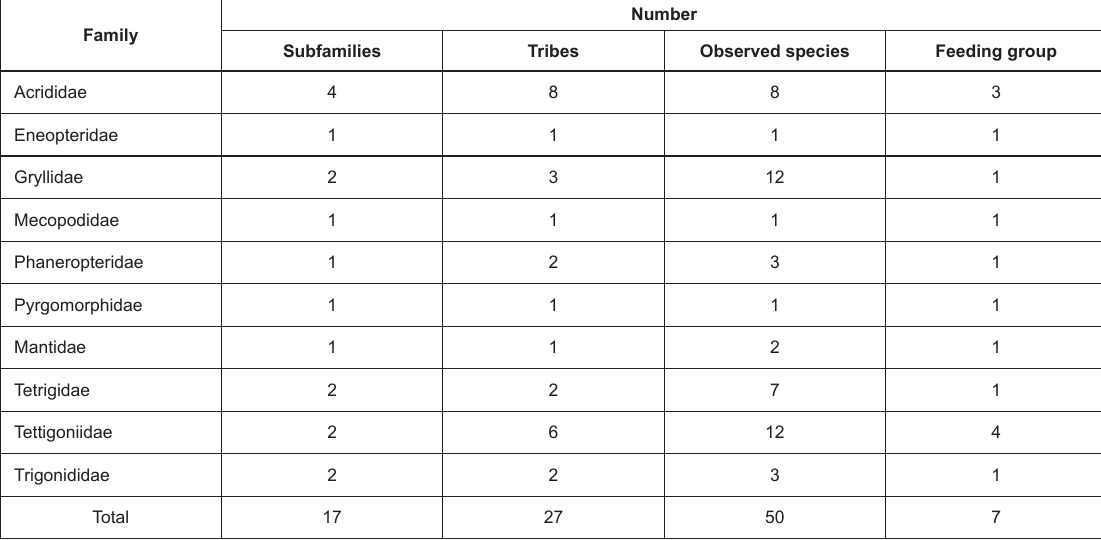
Table 2. Number of families, subfamilies, tribes, species and feeding group of orthopteran species co-occurring in different habitats of Satoyama